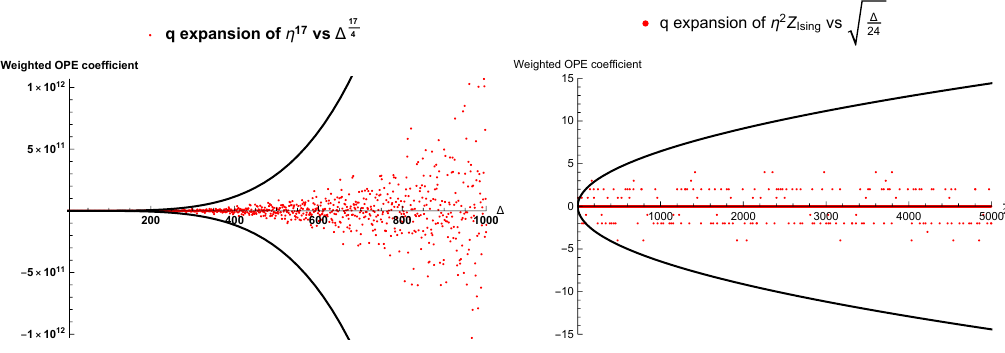
Figure 7 . The q expansion coe(cid:14)cient as a function of (cid:1) is bounded by (cid:1) (cid:1) O = 2 , the black lines are (cid:6) (cid:1) (cid:1) O = 2